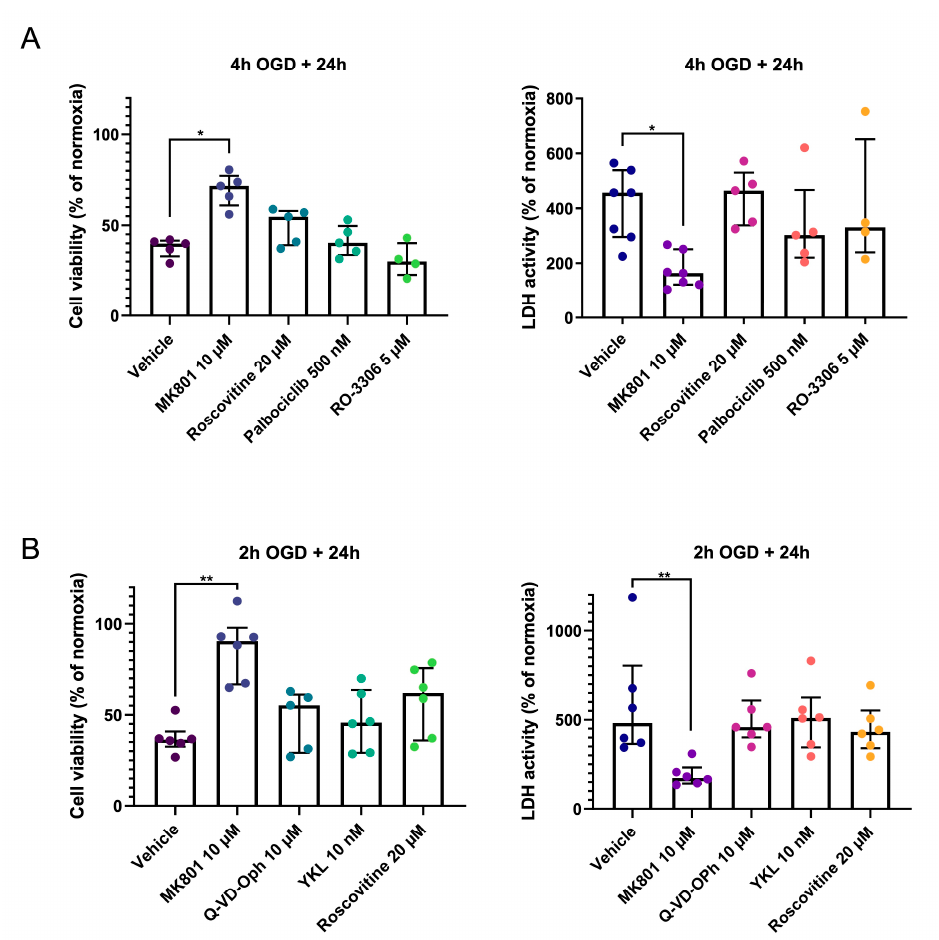
( B ) Representative immunofluorescence staining for Cdk7 (red) and counterstaining with DAPI (blue) in primary cortical neurons obtained from either Cdk7 lox/lox Nex +/+ (“Cdk7 L/L”) or Cdk7 lox/lox Nex Cre/+ (“Cdk7 KO”) mice. Cdk7 is present in virtually all cells obtained from Cdk7 lox/lox mice, while its expression is markedly decreased in the KO condition. ( C ) Viability (CCK8 assay) and cytotoxicity (LDH assay) of primary cortical neurons obtained from either Cdk7 lox/lox Nex +/+ (“Cdk7 L/L”) or Cdk7 lox/lox Nex Cre/+ (“Cdk7 KO”) mice were measured 24 h after OGD. Each dot represents the mean value of 4 replicates for one embryo. Groups were compared pairwise using a Kruskal– Wallis test with Dunn’s multiple comparisons test. Error bars: interquartile range. * p ≤ 0.05; ** p ≤ 0.01; ns = not statistically significant.